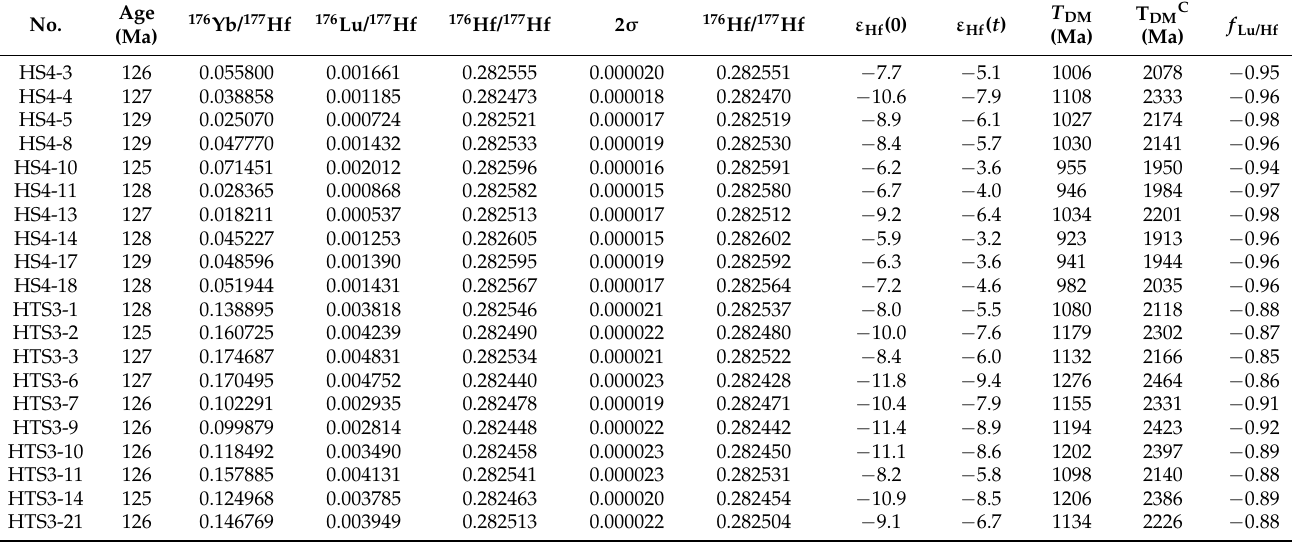
Table 2. Zircon Hf isotopic compositions of quartz monzonites from the Jinling area, western Shandong